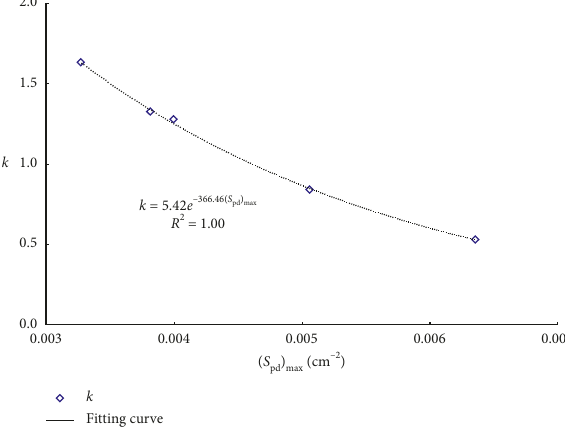
Figure 9: Relationship between k and ( S